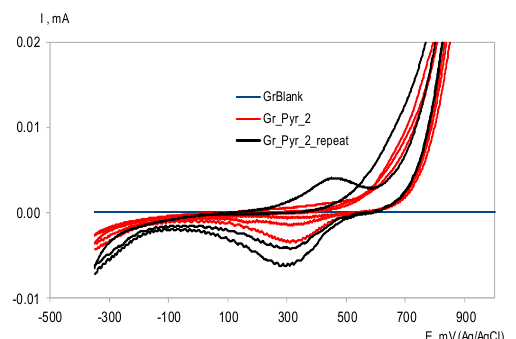
Fig. 4. Cyclic voltammograms measured on electrode Pyr-2 APB in 0.1M, pH 7.4, ν=50mV/sec three consecutive cycles in the potential range -350 - 1500 mV, and then the two cycles in the potential range -350 - 1800 mV. The scale of the axes is changed from